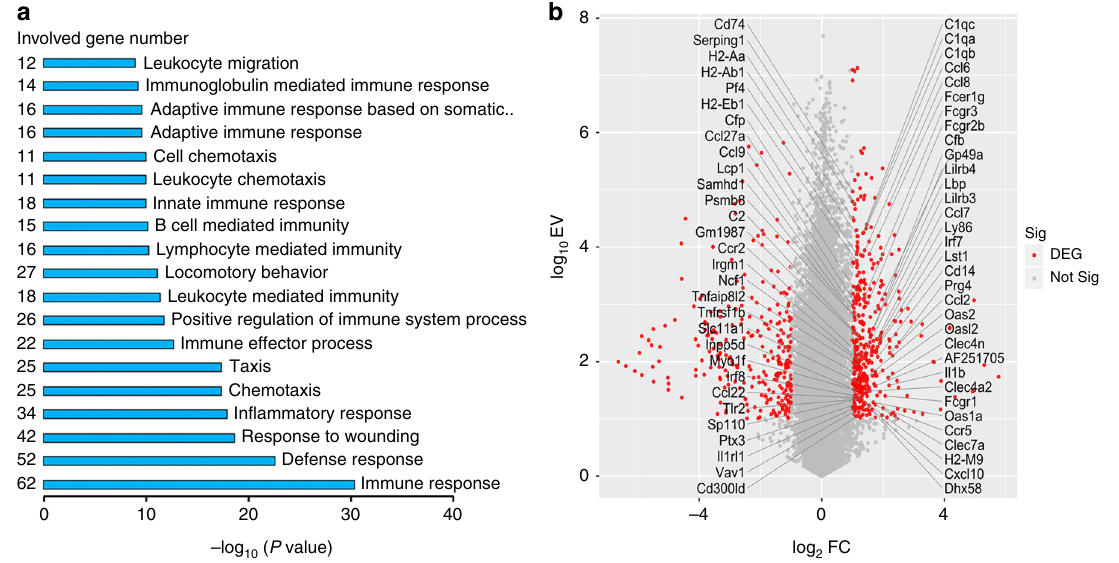
Fig. 3 Functional category enrichment analysis in response to stretch. a Top-ranked upregulated biological processes revealed through a gene ontology analysis, mostly related to in fl ammatory processes. b Volcano plot of differentially expressed genes (DEGs) in immune response gene ontology (GO:0006955). Red points represent DEGs with an expression value ≥ 10 and fold change ≥ 2 or ≤